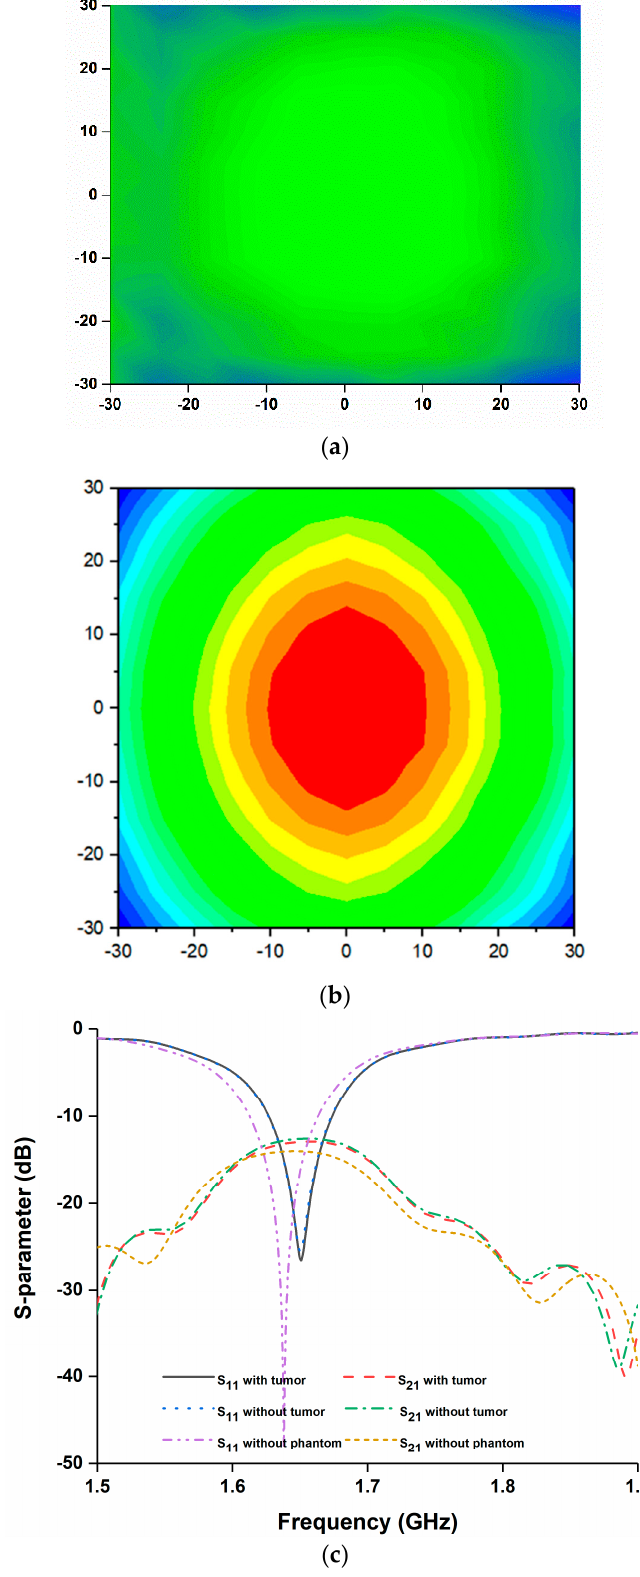
Figure 10. ( a ) Normalized Imaging result of human tissue without tumor; ( b ) Normalized Imaging result of human tissue with tumor; ( c ) S-parameters with and without tumor.